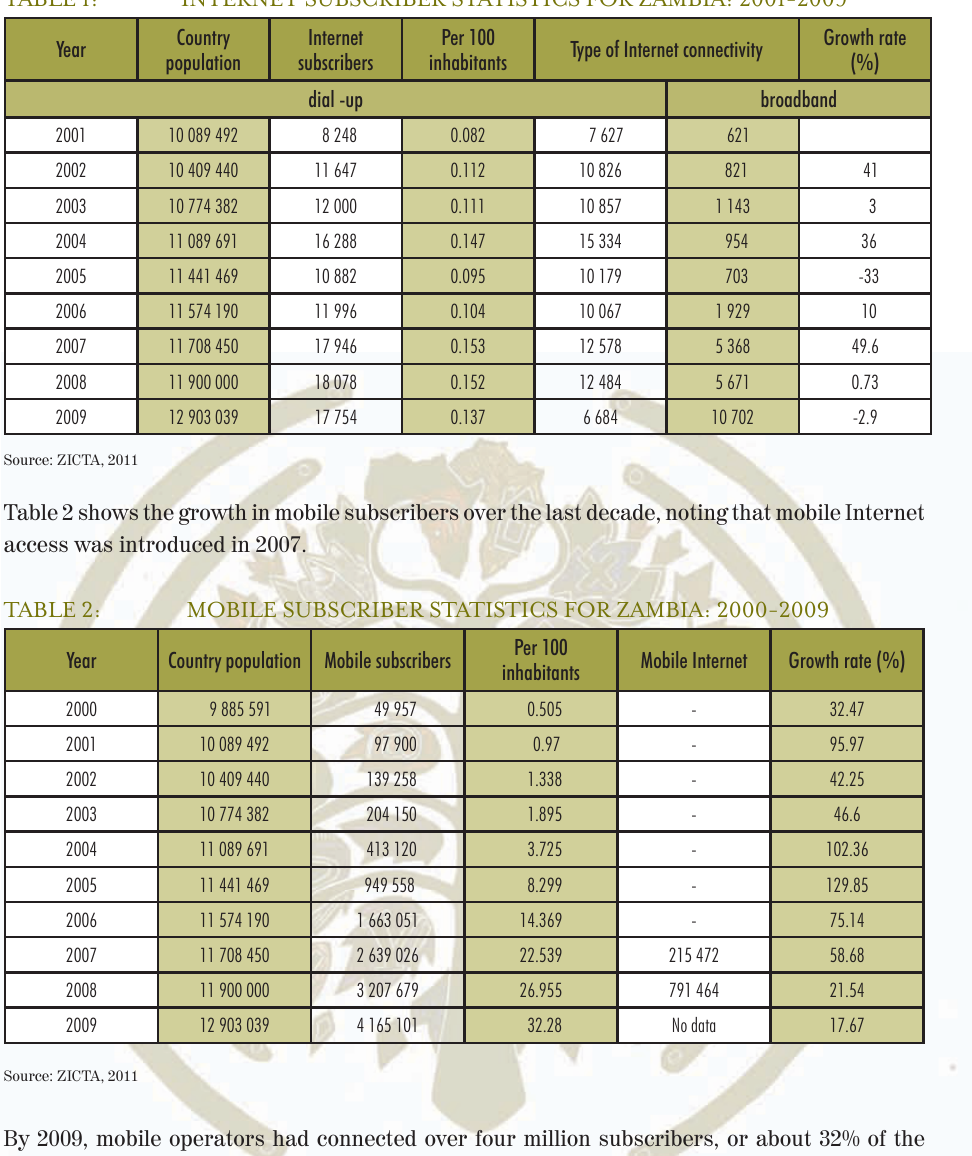
INTERNET SUBSCRIBER STATISTICS FOR ZAMBIA: 2001-2009